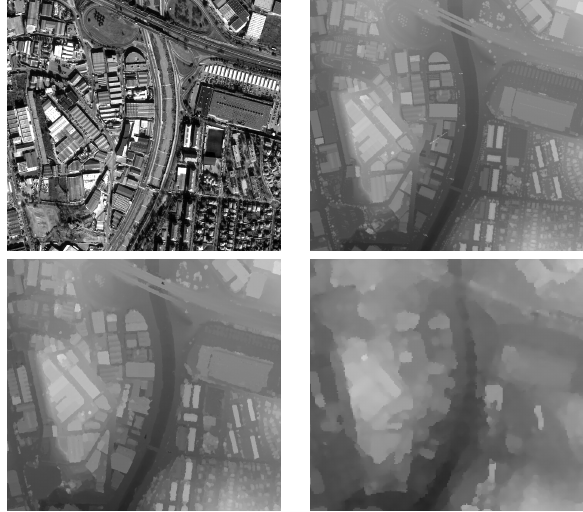
Figure 3: Detail of MGM8 results on the Terrassa area. Top row: Pleiades ortho image, LIDAR reference. Bottom Row: Pleiades DSM, Cartosat-1